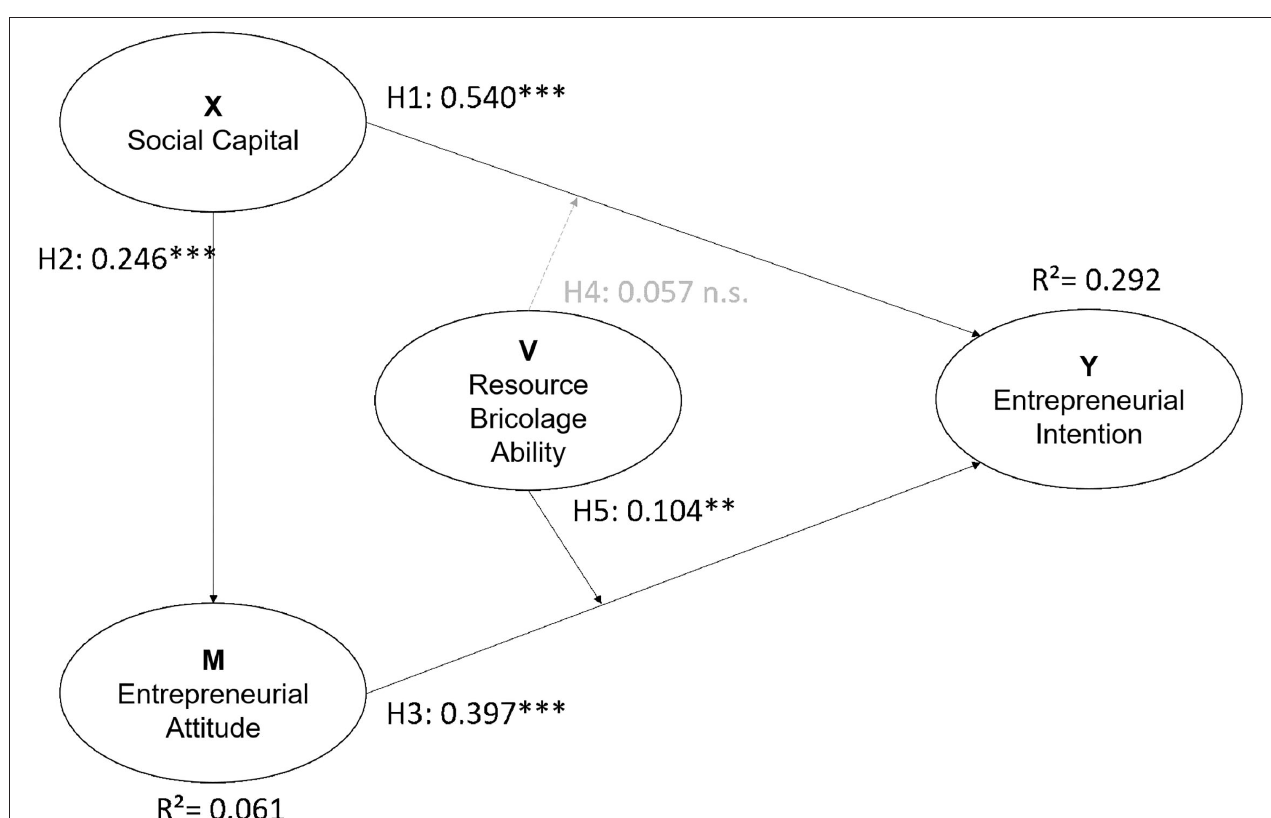
FIGURE 4 | The hypotheses model with standardized path coefficient tested results.